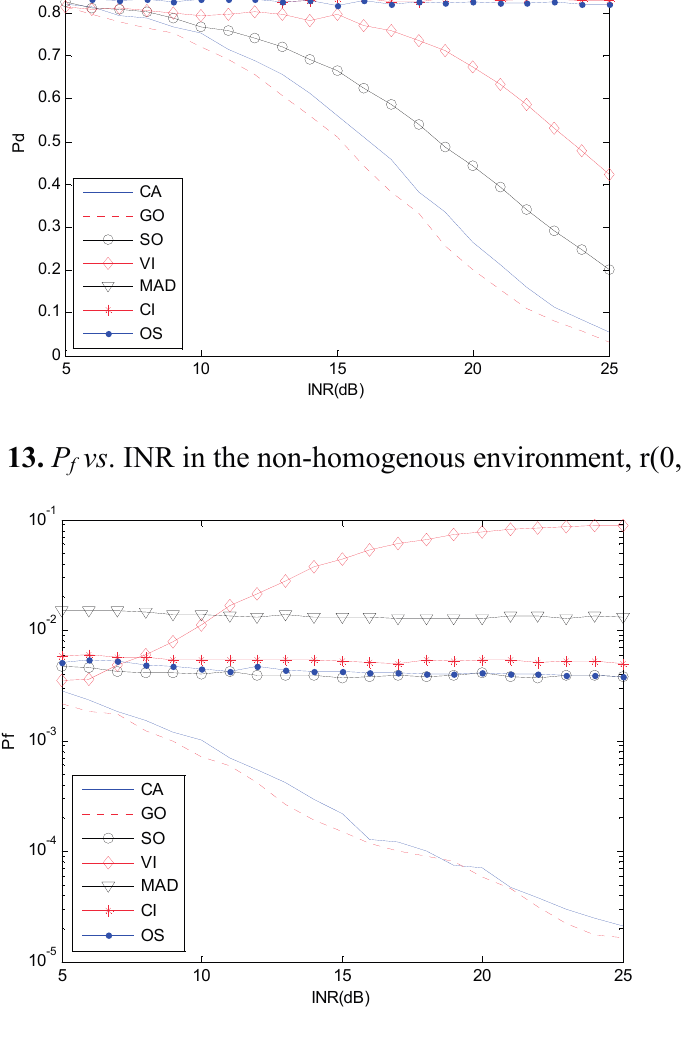
vs . INR in the non-homogenous environment, Figure 14. P f